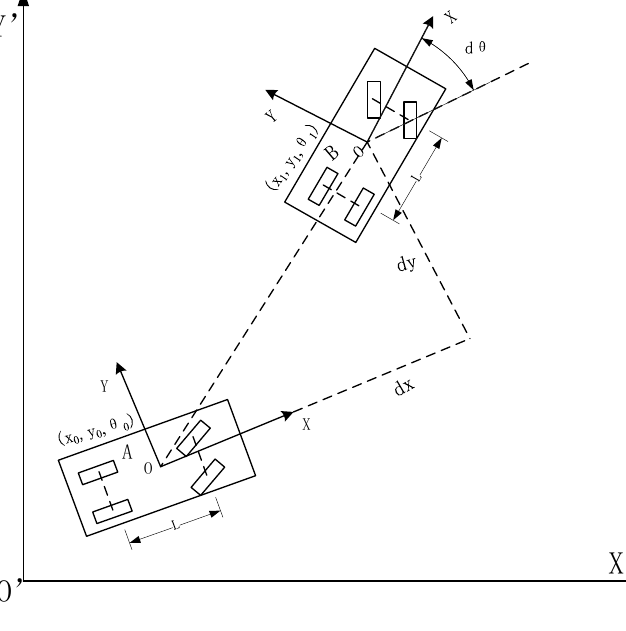
Figure 5. Kinematics model of AGV.